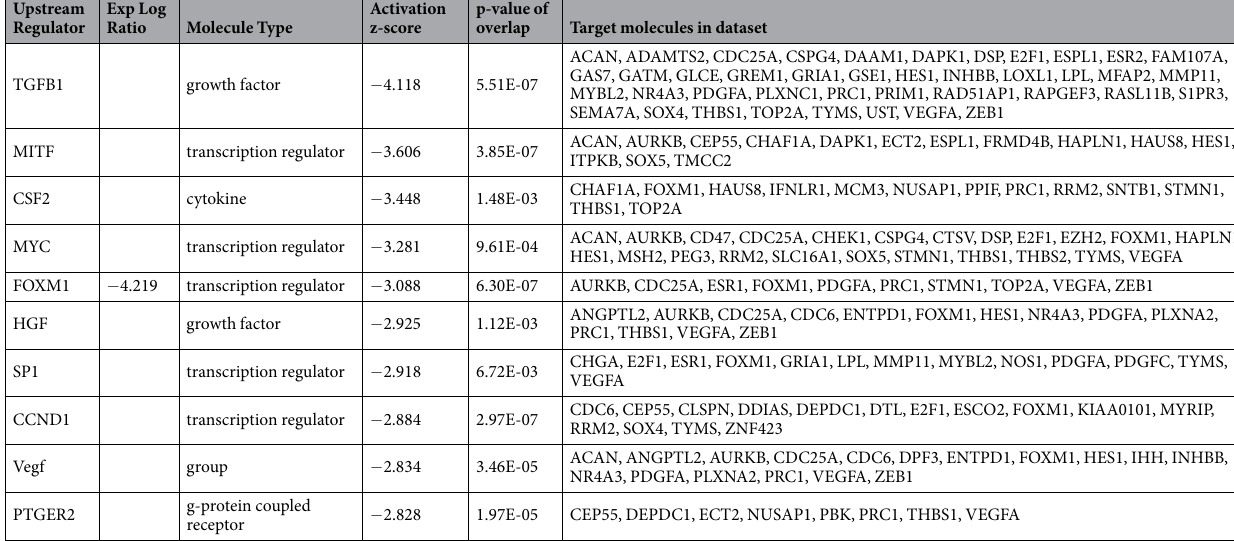
Table 3. Top 10 inhibited upstream regulators of negatively correlated miRNAs and targets identified by ingenuity IPA analysis 19